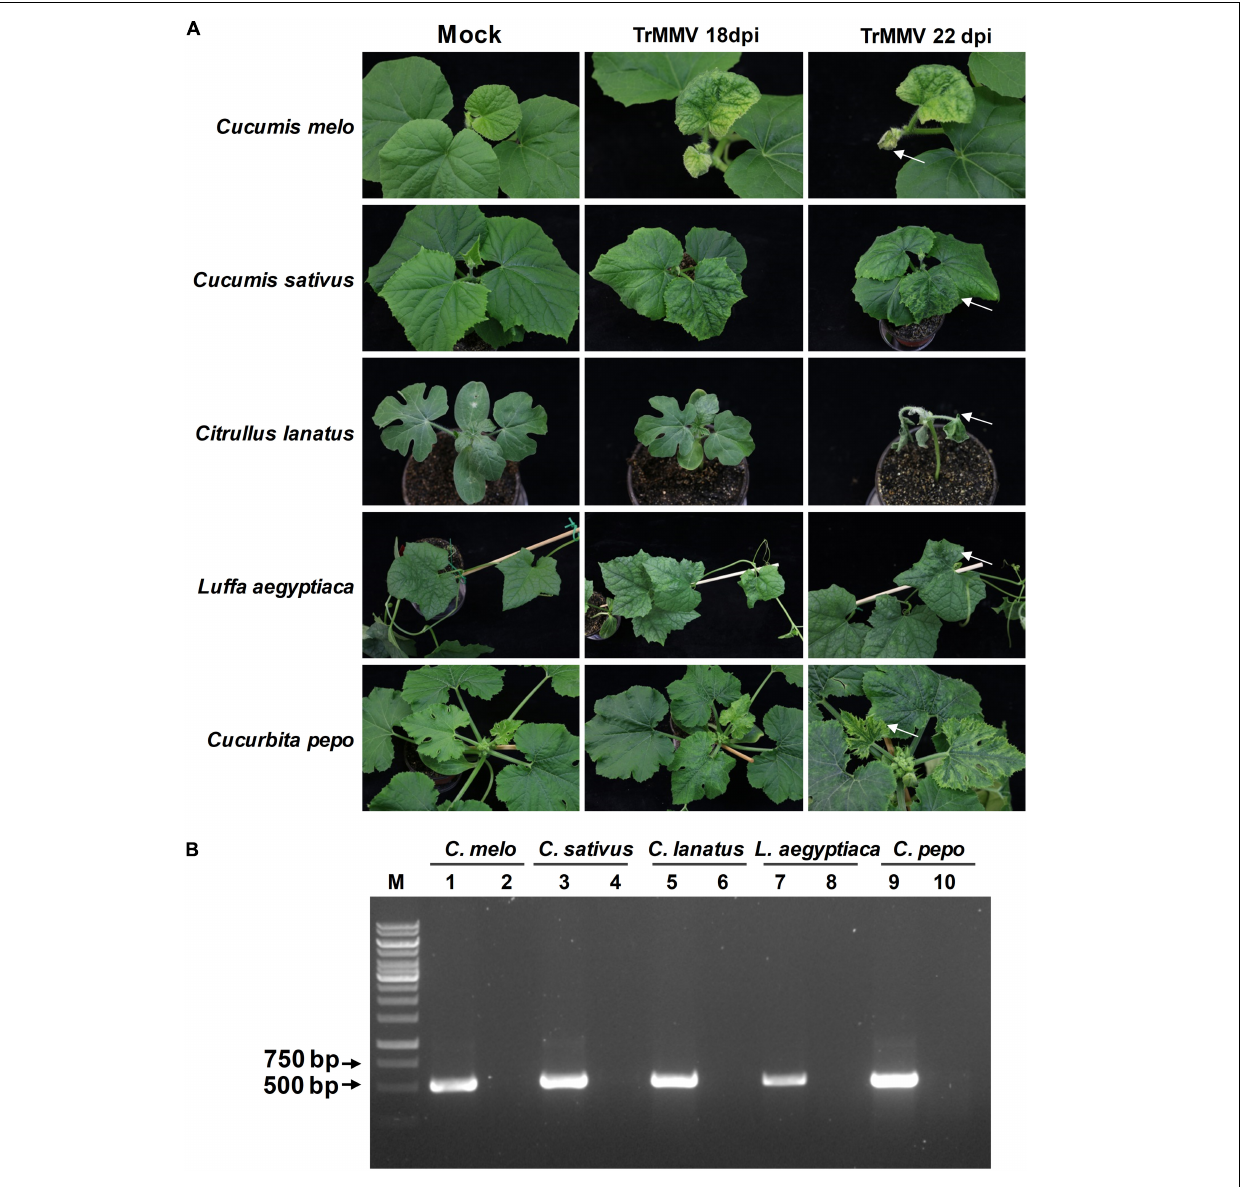
FIGURE 5 | Infectivity of TrMMV on five common cucurbitaceous crops. (A) Typical virus infection symptoms of Cucumis melo , C. sativus , C. lanatus , Luffa aegyptiaca , and Cucurbita pepo plants inoculated with pCB301-TrMMV at 18 and 22 dpi, respectively. Arrows indicate that TrMMV causes the symptoms of systematic leaf necrosis in C. melo , leaf crinkle in C. sativus , wilting in C. lanatus plant, leaf crinkle in L. aegyptiaca , and leaf edge chlorosis in C. pepo . (B) RT-PCR detection of TrMMV in systemic leaves of inoculated plants using TrMMV-specific primers. Lane M, GeneRuler 1kb DNA ladders (Thermo); lane 1, 3, 5, 7, 9, samples collected from systemic leaves of inoculated C. melo , C. sativus , C. lanatus , L. aegyptiaca , and C. pepo plants, respectively; lane 2, 4, 6, 8, 10, mock plants inoculated with the empty pCB301 vector ( C. melo , C. sativus , C. lanatus , L. aegyptiaca , and C. pepo plants,